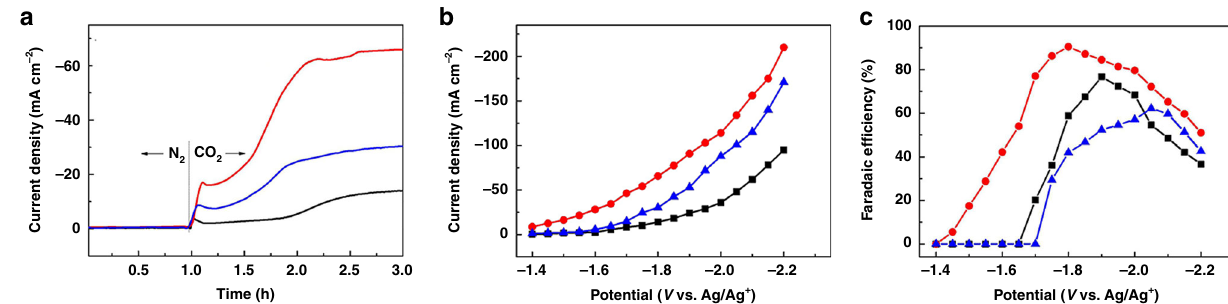
Fig. 3 Electrochemical reduction of CO 2 over Cu 2 (L)-t/CP (black lines), Cu 2 (L)-e/Cu (red lines), and HKUST-1-e/Cu (blue lines). a Plot of current density vs. time. b Plot of current density vs . potential. c Plot of FE HCOOH